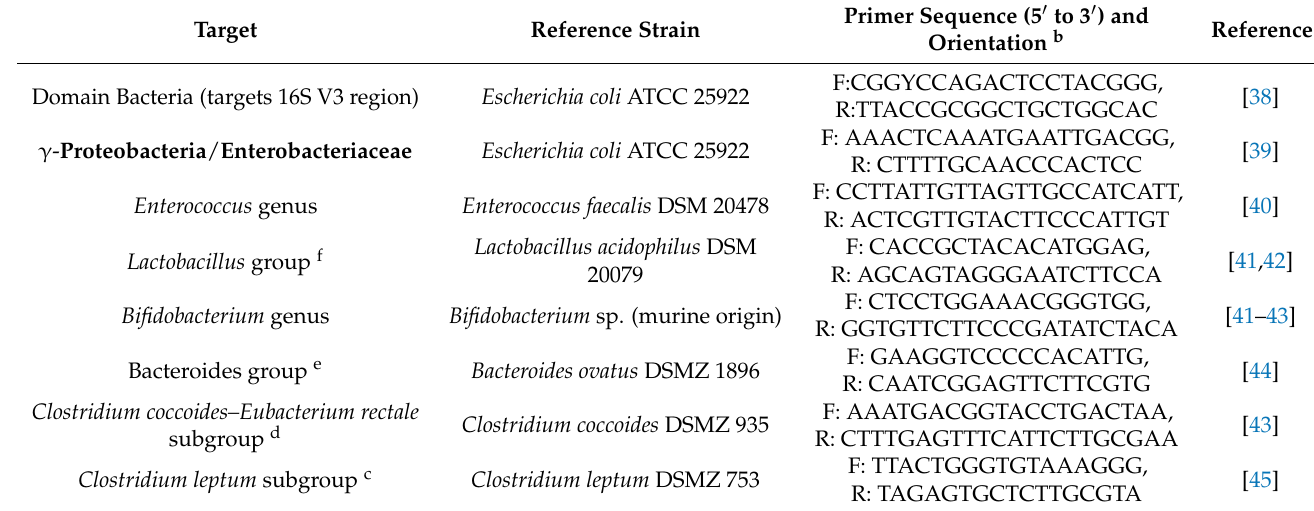
Table 1. 16S rRNA primer used for quantitative real-time-PCR a